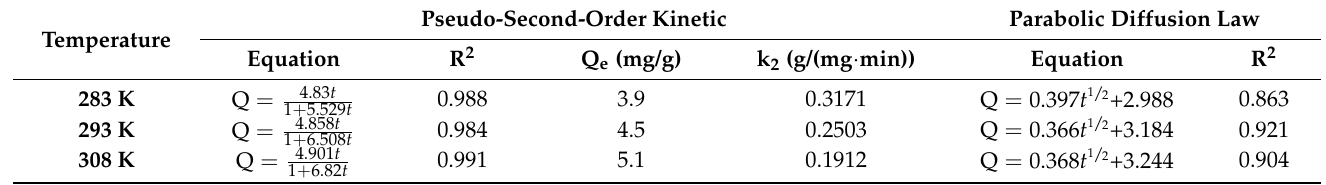
Table 4. Equations and fitting parameters derived from the kinetics adsorption data of schwertman- nite